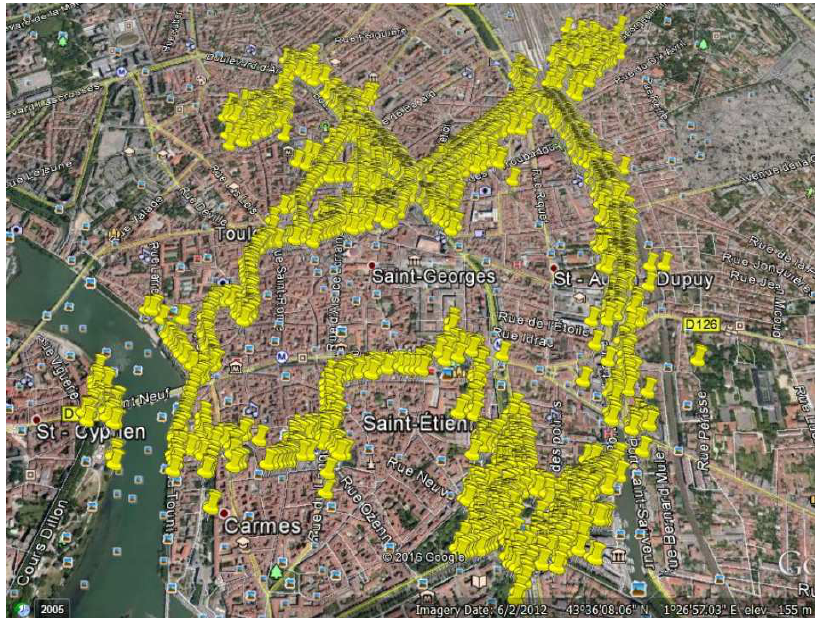
Figure 6. Toulouse trees visualized using a rendering budget of 2 million points (left) and 5 million points (right).